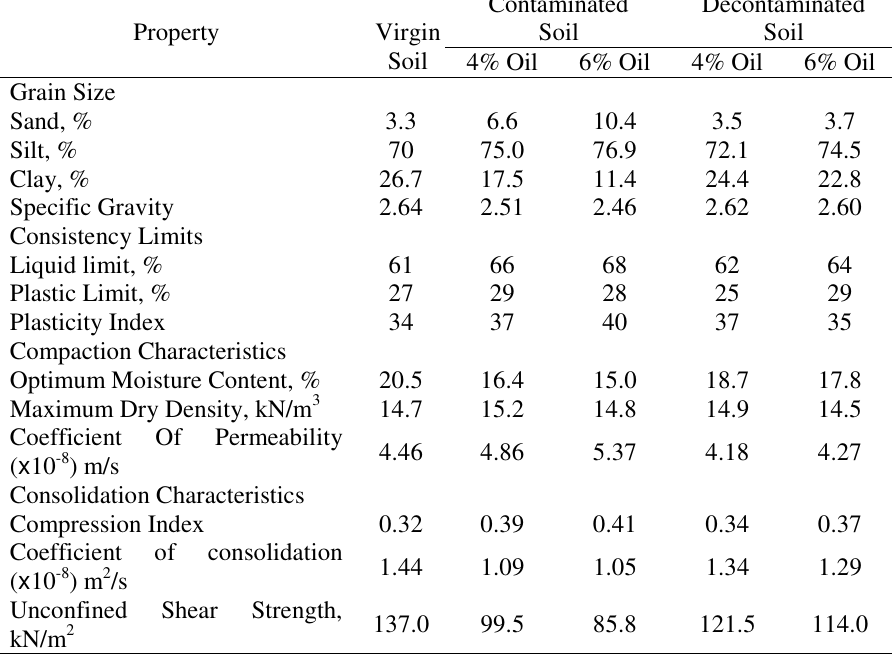
Table 2. Comparison of properties of virgin, contaminated and decontaminated